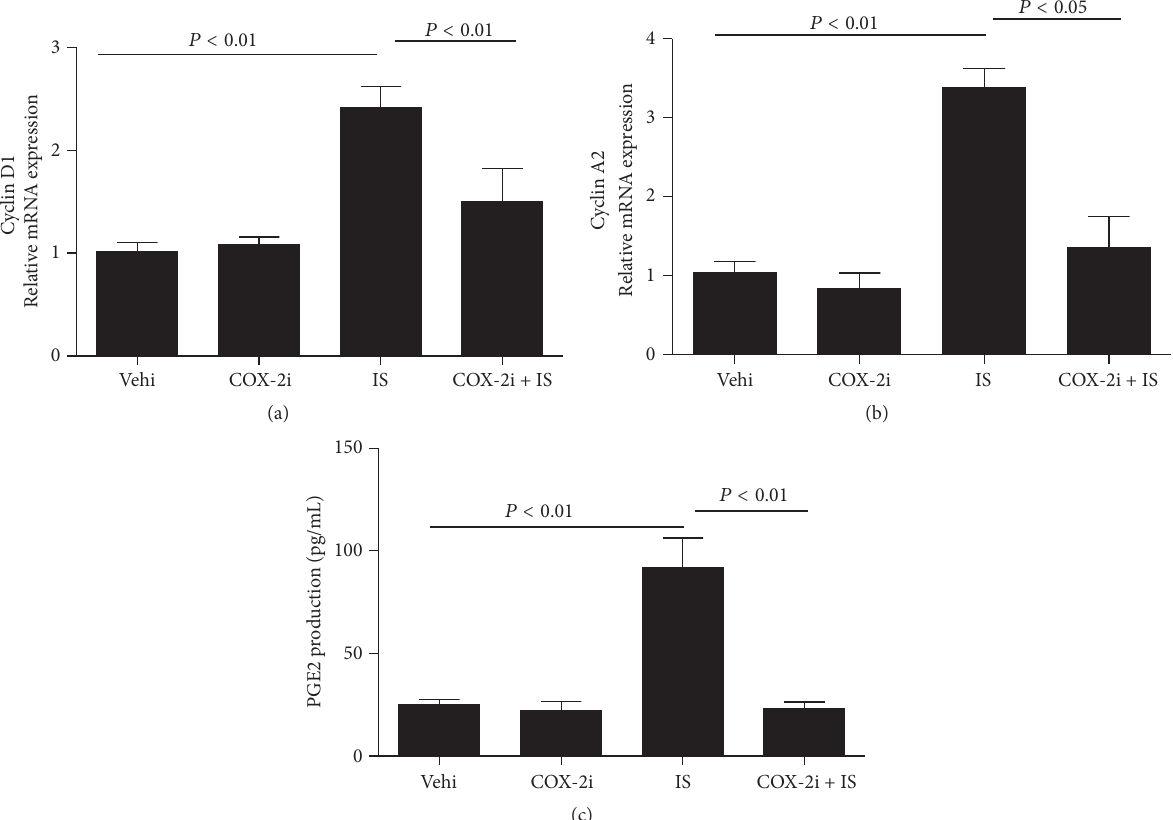
Figure6:EffectsofCOX-2inhibitiononthemRNAexpressionsofcyclinD1andcyclinA2andtheproductionofPGE2.(a)mRNAexpression of cyclin D1 determined by qRT-PCR; (b) mRNA expression of cyclin A2 determined by qRT-PCR; (c) enzyme immunoassay of PGE2 in the medium. Values are means ± SD; 𝑛 = 6 in each